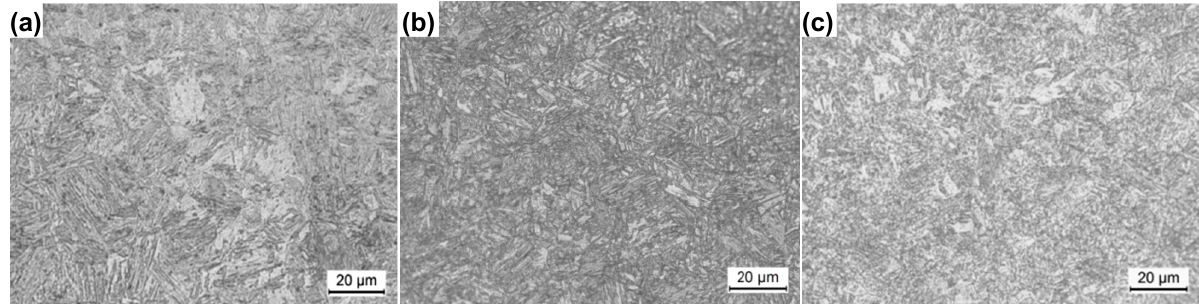
Figure 6. Microstructure of hot-formed parts in different positions: ( a ) top; ( b ) side; and ( c ) bottom.